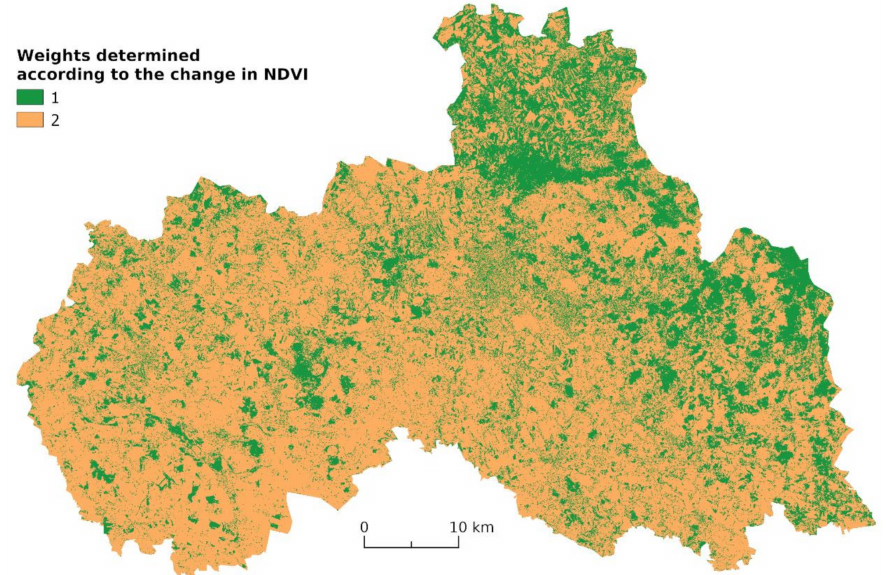
Figure 11. Raster with the resulting weight V according to the change in NDVI from 2017 to 2018 for the Liberec